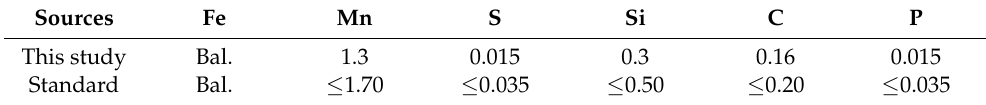
Table 1. Comparison of chemical composition (wt.%) of Q345 steel in this study with standard values. Sources